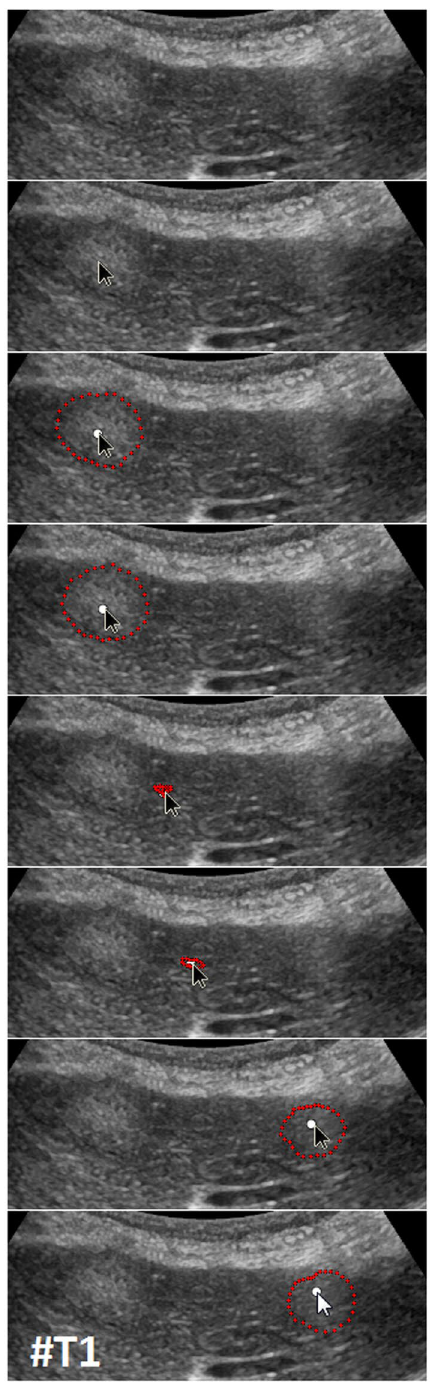
Figure 9. Several screenshots from a video where two metastases of a colon cancer in one image were segmented interactively (from the top to the bottom). The upper image presents the native acquisition. The next image presents the position of the mouse cursor where the user started the interactive segmentation. The third image presents the first segmentation result (red dots) at the position of the mouse cursor. In the following image, the user moved the mouse and therefore the seed point (white dot) for the segmentation slightly to the right to get a better segmentation. After being satisfied with the segmentation of the first metastasis, the user moved the mouse to the second metastasis on the right. As seen in the screenshots of the video, the resulting segmentation contours (red dots) collapsed, because in this area, no metastasis is present (note: the screenshots present only a fraction of the whole video). When the user reached the second metastasis on the right, the red segmentation contour automatically expanded again and adapted to the metastasis border (lower two images). The lower image presents the final outlining of the second metastasis where the user stopped the interactive segmentation